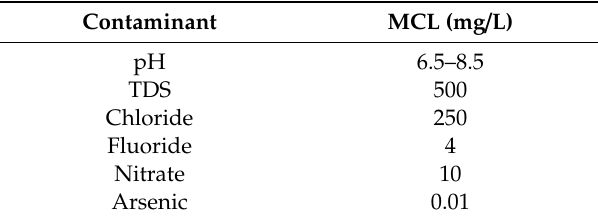
Table 2. Standards for groundwater quality by EPA and WHO (EPA: US environmental protection agency, WHO: world health organization, MCL: maximum contamination